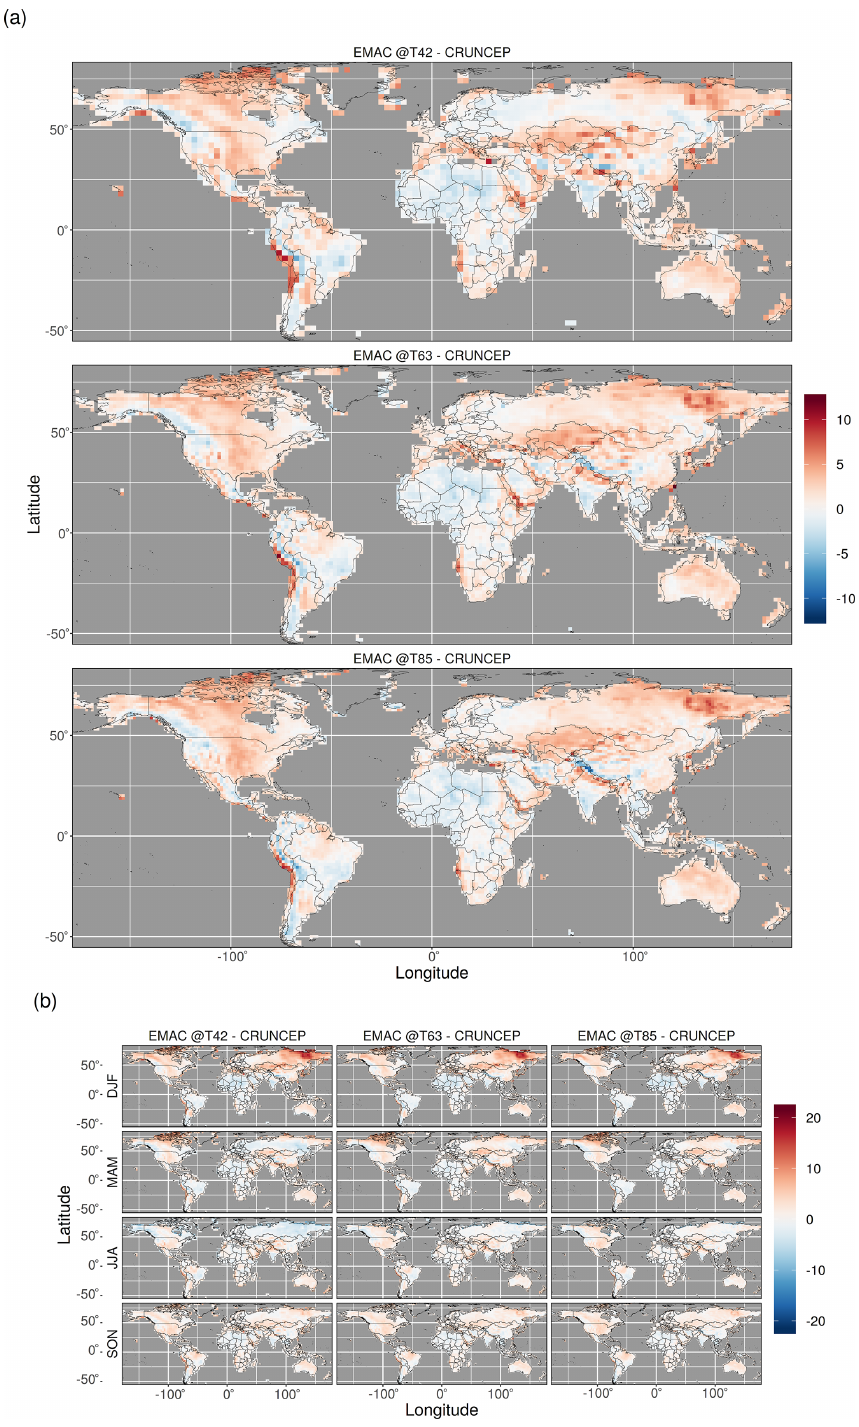
Figure C2. The (a) mean annual temperature bias and (b) mean seasonal temperature bias between the observed CRUNCEP dataset (1981– 2010) and EMAC simulations (last 50 years of